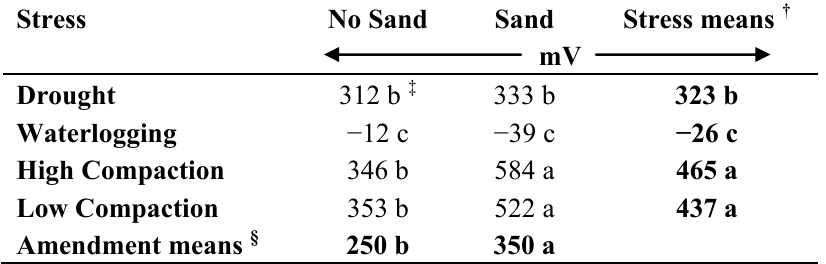
across four stress h